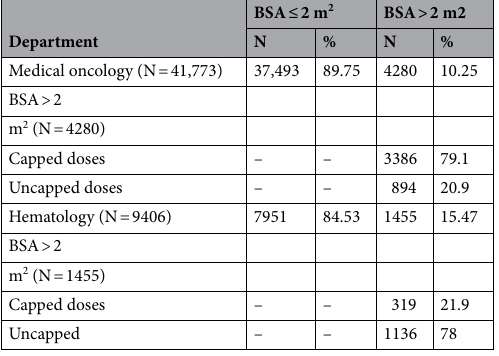
Table 3. Chemotherapy prescriptions according to medical indication and body surface